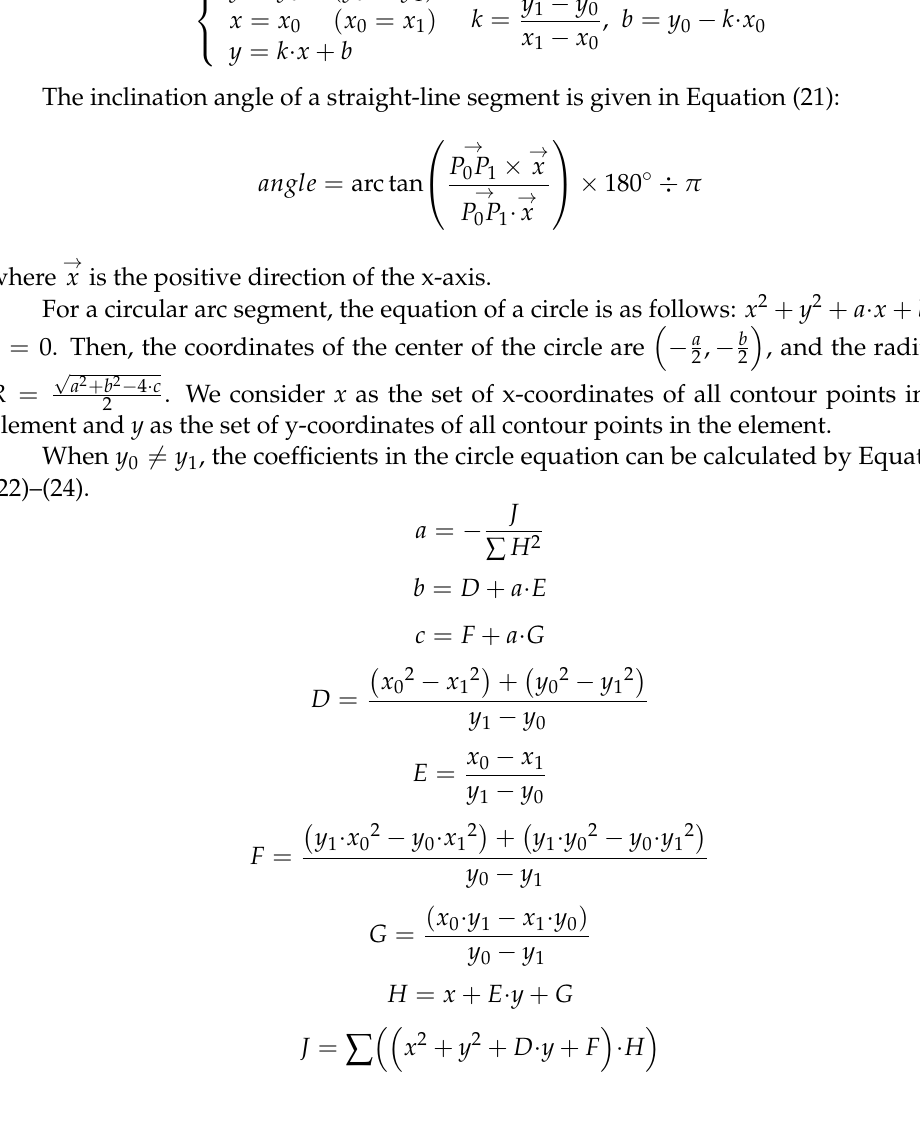
Figure 21. The graphic element fitting results were not